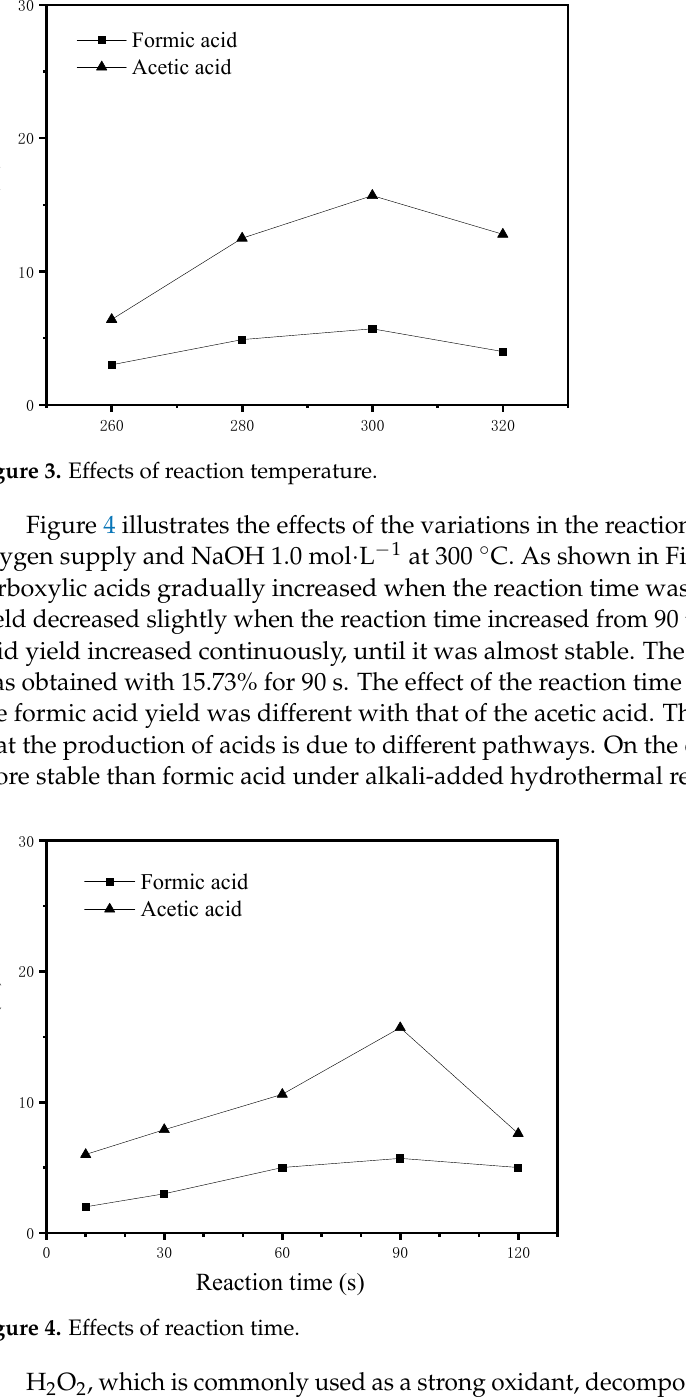
Figure 2. Effects of NaOH concentration.